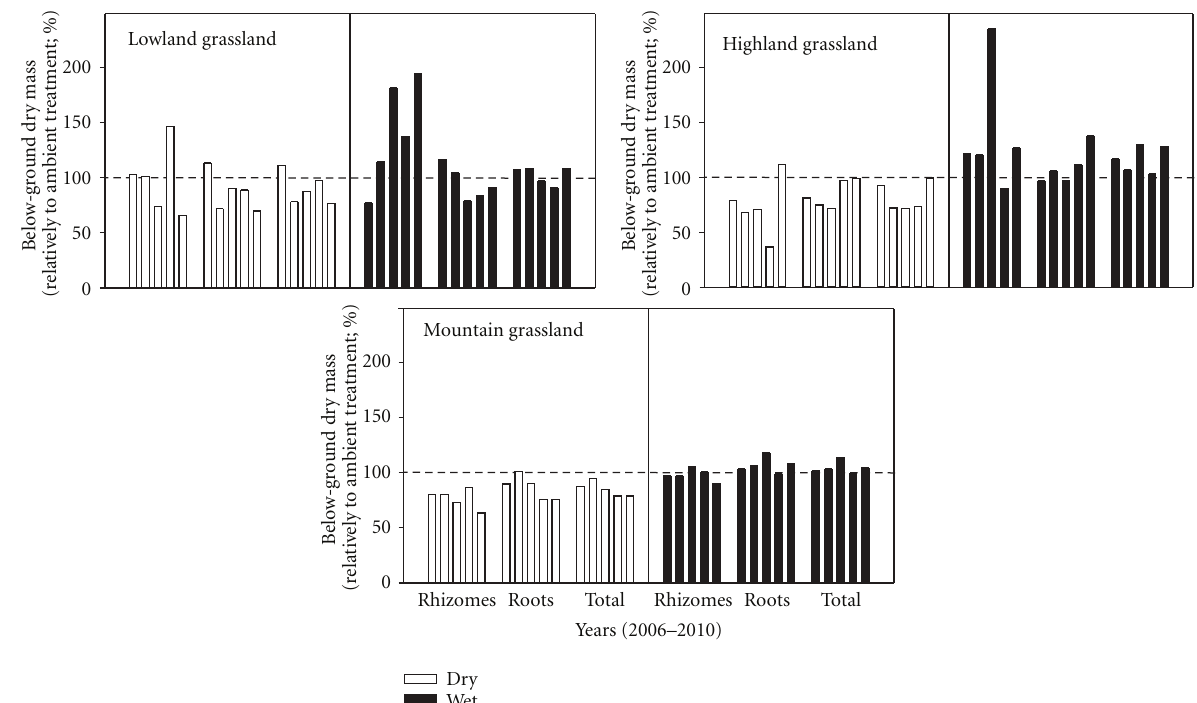
Figure 5: Percentage increase or decrease in dry mass of rhizomes, roots, and total below-ground plant biomass (ambient treatment = 100%) in dry and wet treatments recorded in five years